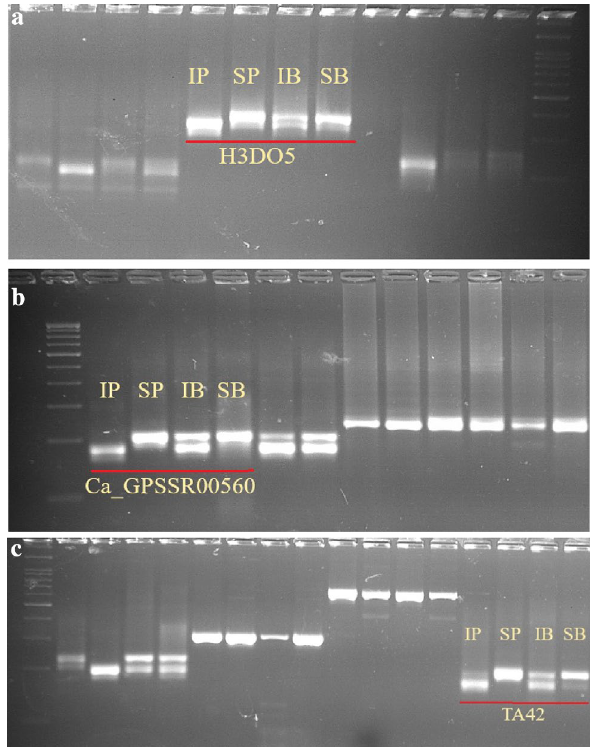
Figure 3. ( a ) Bulked Segregant Analysis (BSA) of H3DO5 showing putatively linked marker. ( b ) Bulked Segregant Analysis (BSA) of Ca_GPSSR00560 showing putatively linked marker. ( c ) Bulked Segregant Analysis (BSA) of TA42 showing putatively linked marker. IP indeterminate parent, SP semi-determinate parent, IB indeterminate bulk, SB semi-determinate